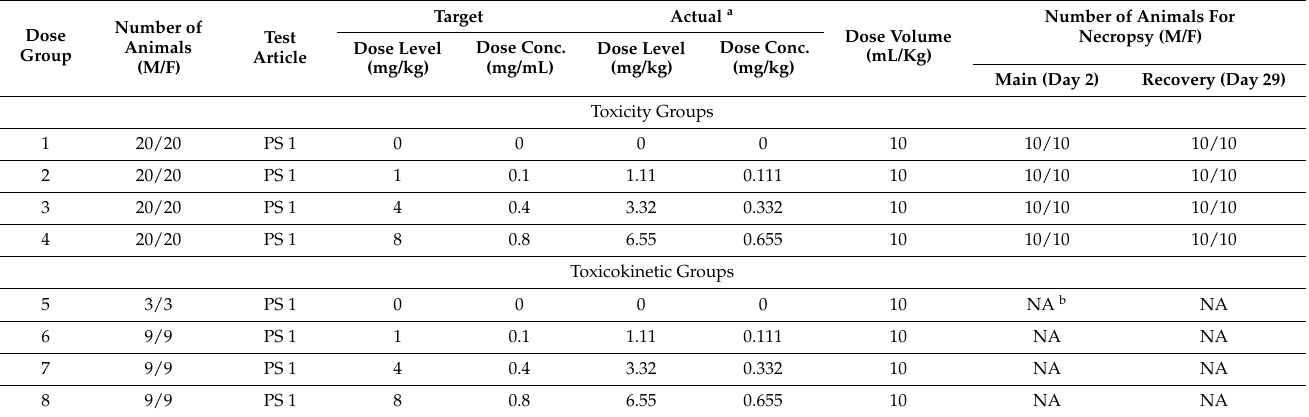
Table 1. Group assignments and dose levels (rat study).